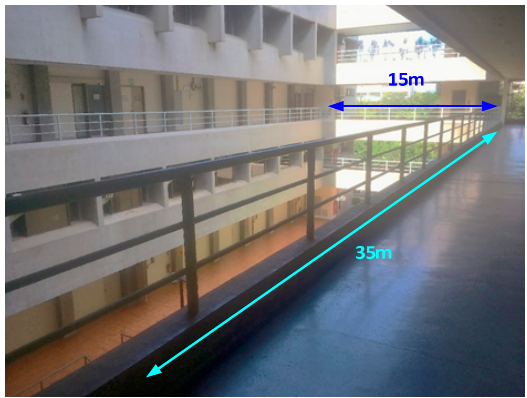
Figure 12. ICP performances of the first/second experiments.